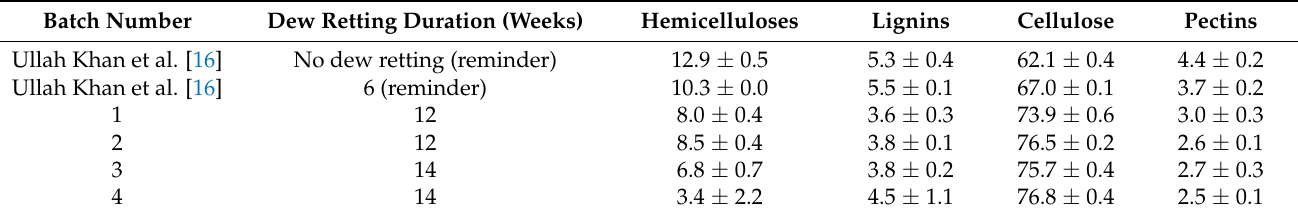
Table 4. Chemical composition of manually extracted fibres as a function of the dew retting duration, including the values from Khan et al. [16] corresponding to no dew retting and six weeks of dew retting (% of dry